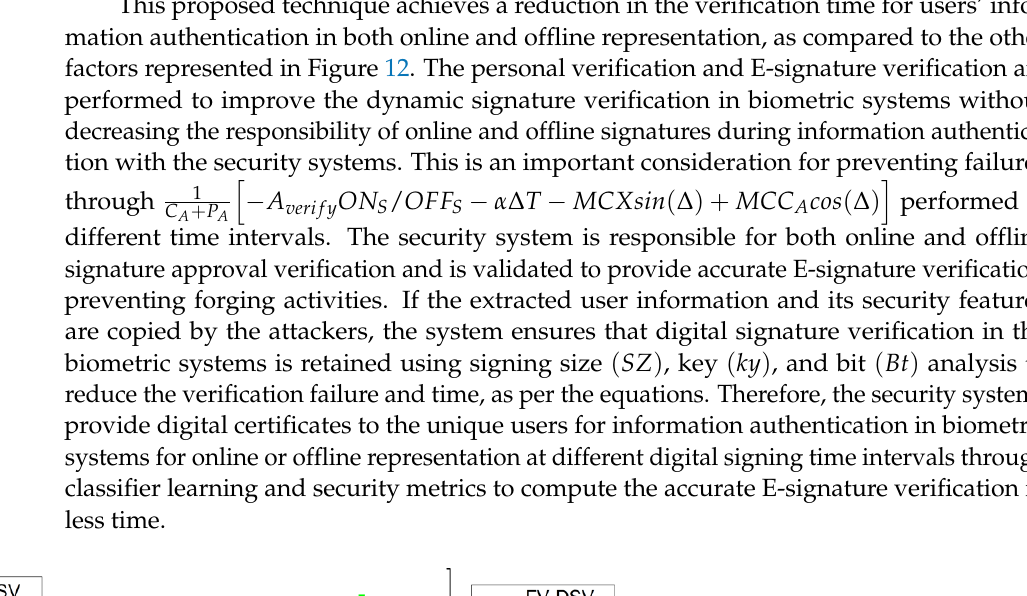
Figure 11. Verification Failure Ratio for ( a ) different session rate ( b ) Segregation.